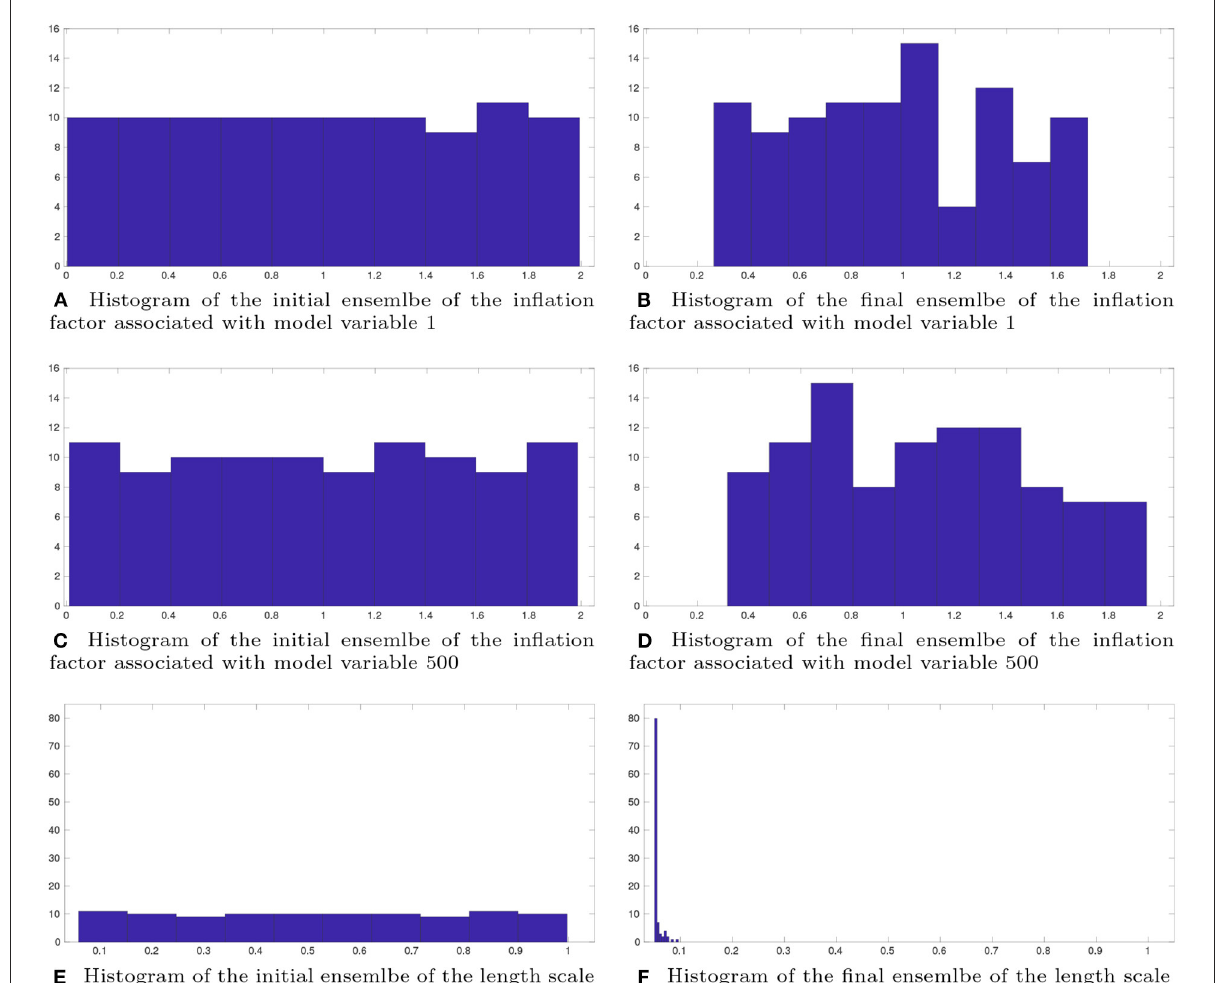
FIGURE9 Histograms of the initial (left) and final (right) ensembles, with respect to the inflation factors associated with model state variables 1 (A,B) and 500 (C,D) , and the length scale (E,F) ,